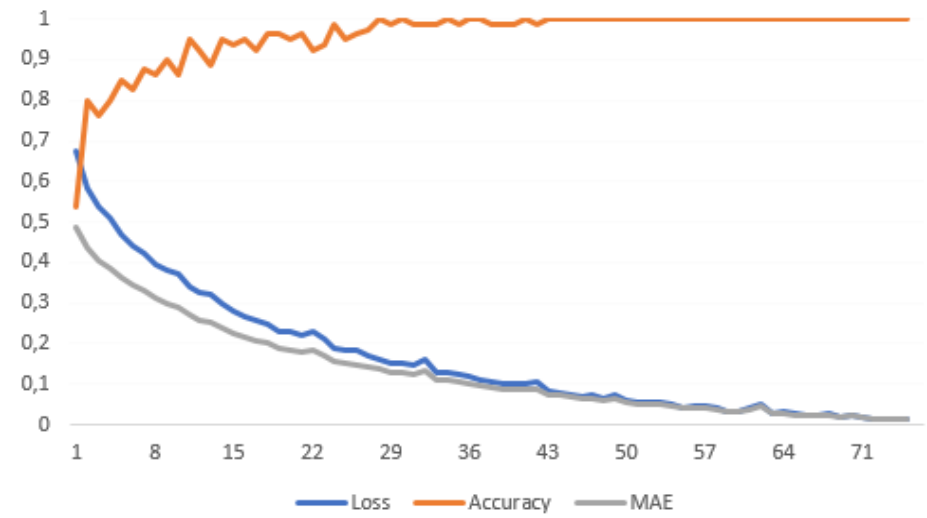
Figure 1. The plot of loss, accuracy and MAE versus the number of epochs during the training step. Throughout the 85 training epochs, the model achieved a very good performance with the accuracy ranging between 99.76% and 100%. After achieving an excellent performance of the model during the training step, we moved to testing the model on an independent patient cohort.